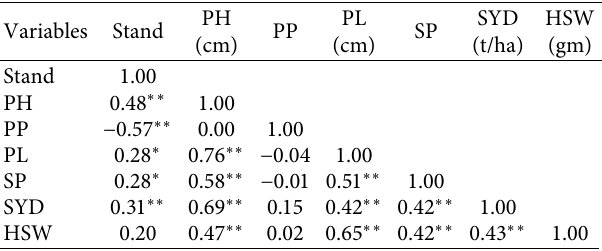
Table 8: Pearson correlation between agronomic attributes of two sweet lupine